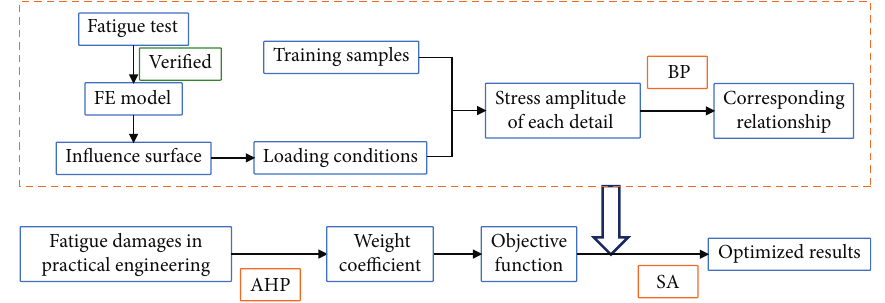
Figure 2: Flow chart of method in this paper.